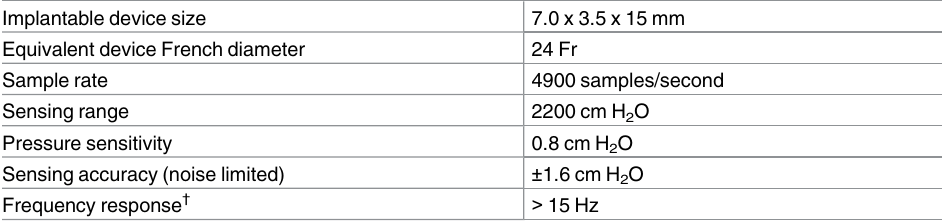
Table 1. Prototype PressureSensor Bench Test Summary. Implantable device